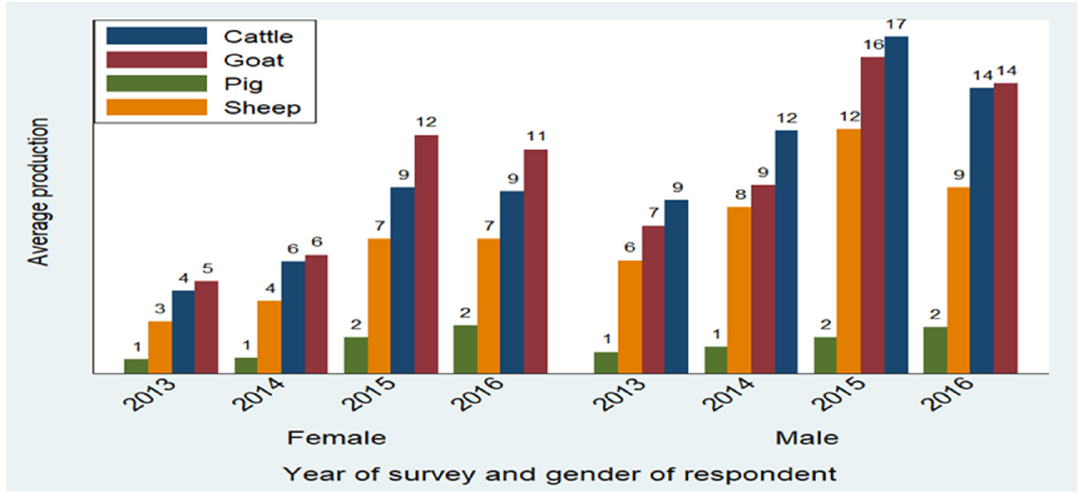
Figure 3. Average livestock production by gender and assistance status of the respondent.